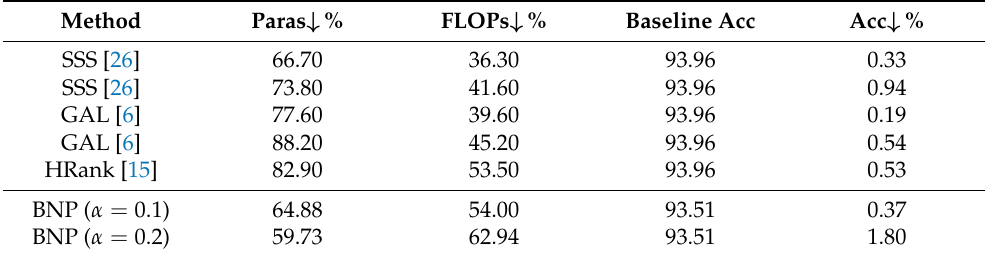
Table 1. Network pruning results of VGGNet on CIFAR-10. In all tables, Paras ↓ denotes parameters reduction, FLOPs ↓ represents FLOPs reduction, and Acc ↓ means accuracy loss on test